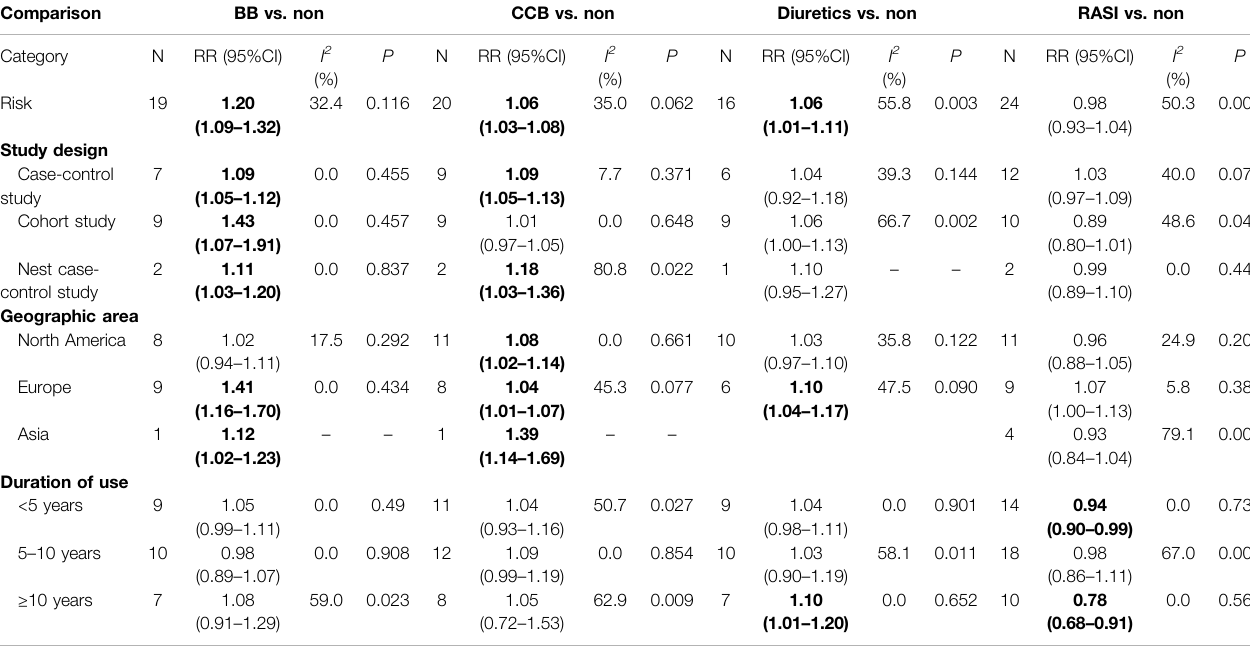
TABLE 2 | The results of the association between antihypertensive medication use and breast cancer risk. Comparison BB vs. non CCB vs. non Diuretics vs. non RASI vs.